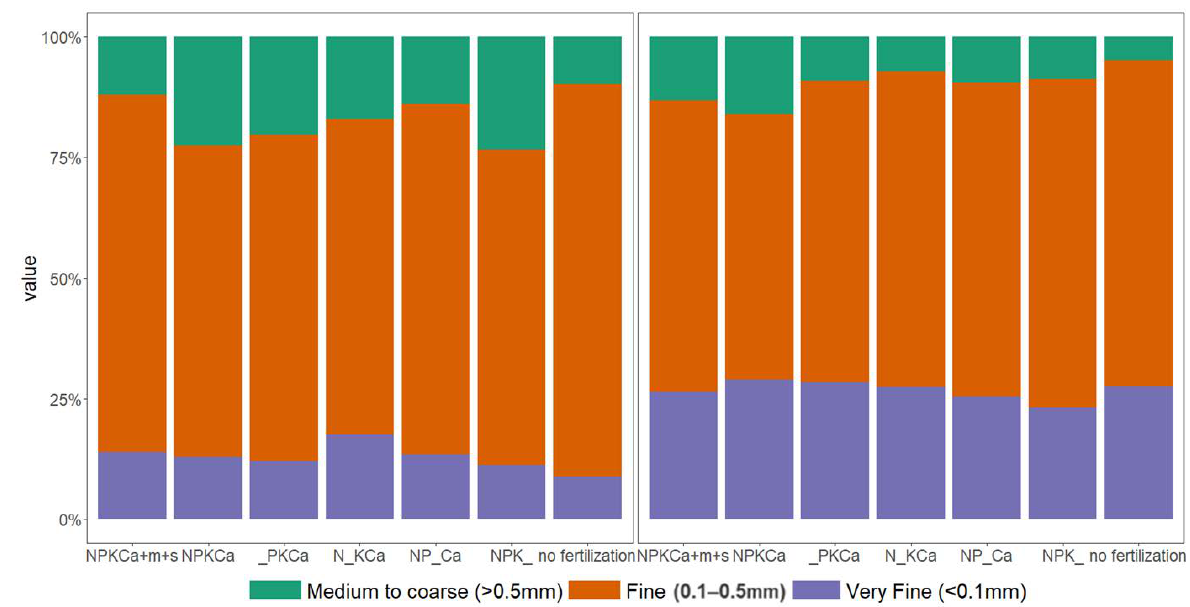
Figure 5. Proportion of fine root diameter class to total root length in % at early growth stage (13 June, left panel) and late growth stage (10 September, right panel) of sugar beet for seven fertilizer treatments grown in 2019 at the long-term fertilizer experiment Dikopshof, Germany. Median values of root length per root diameter class were used to represent the